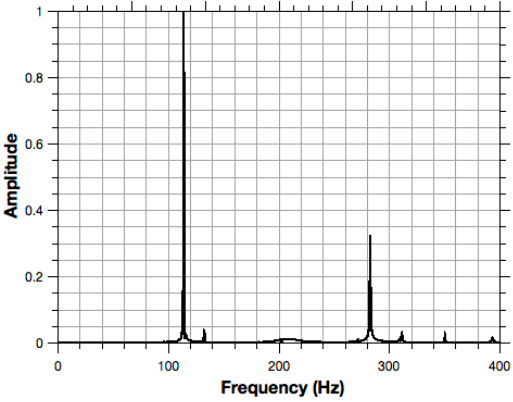
Figure 4. The oscillations inside the initial cylinder.